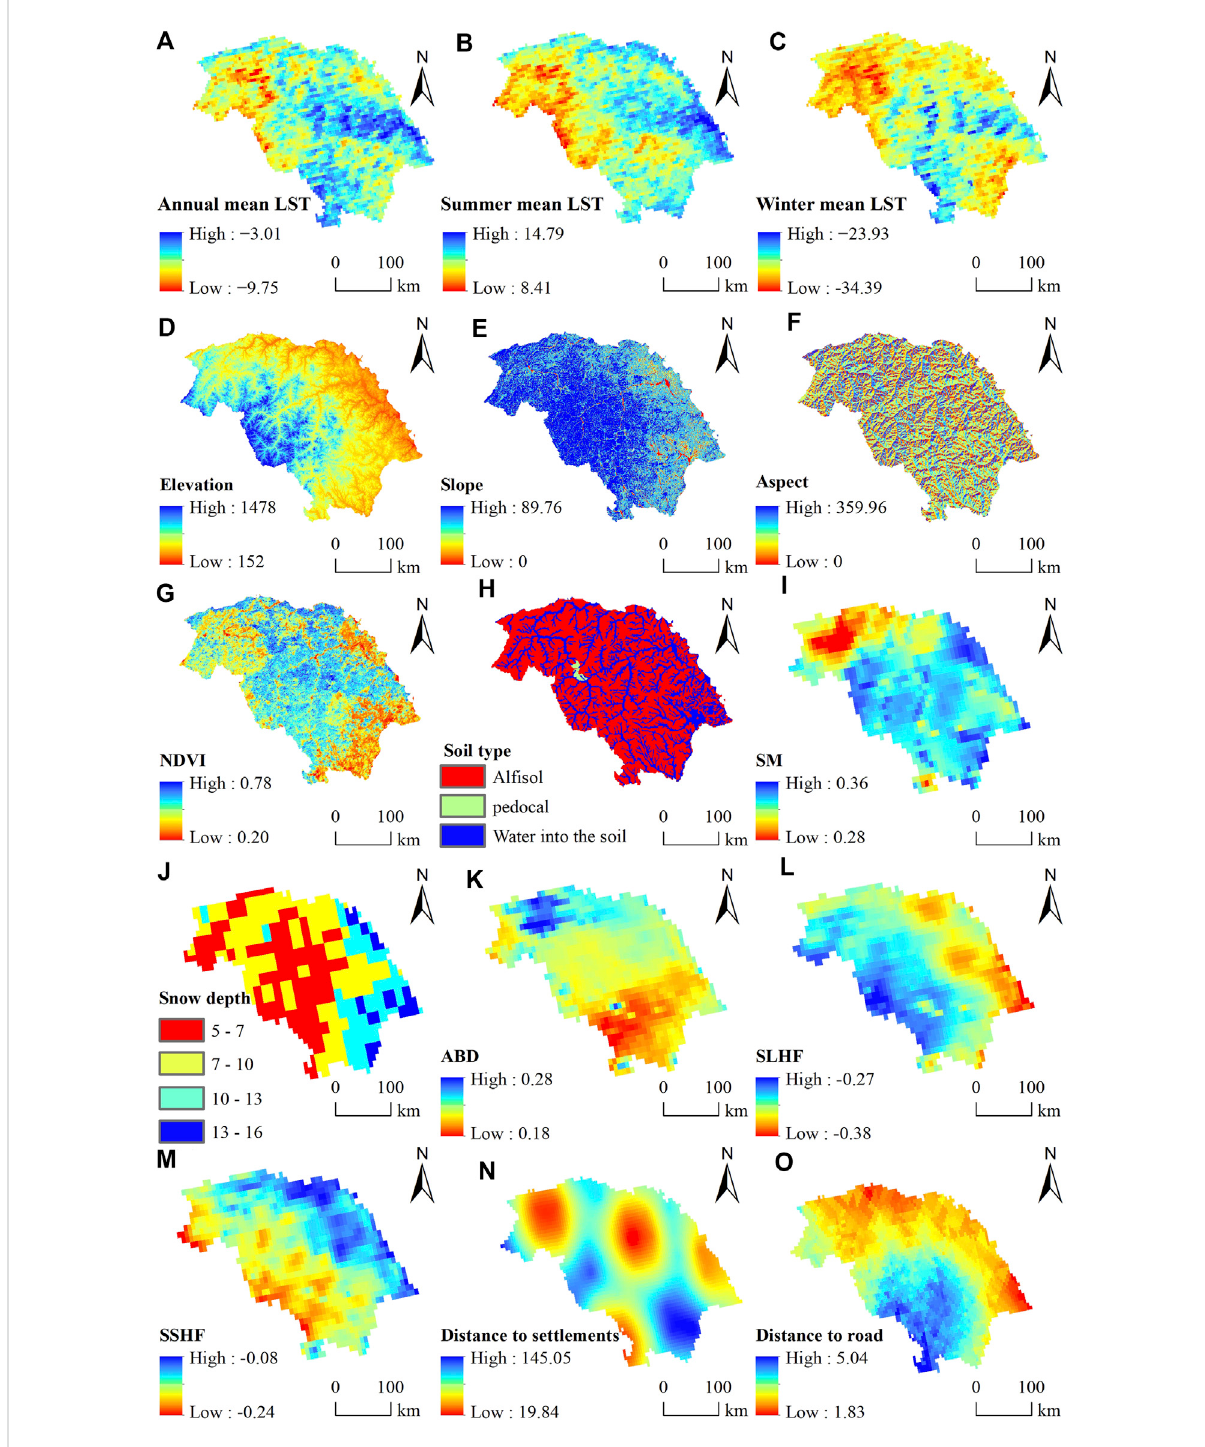
FIGURE 5 Spatial distribution of in fl uencing factors: (A) Annual mean LST ( ° C), (B) summer mean LST ( ° C), (C) winter mean LST ( ° C), (D) Elevation (m), (E) Slope ( ° ), (F) Aspect ( ° ), (G) NDVI, (H) Soil type, (I) SM (%), (J) Snow depth (cm), (K) ABD (%), (L) SLHF (w/m 2 ), (M) SSHF (w/m 2 ), (N) Distance to settlements (km) and (O) Distance to roads